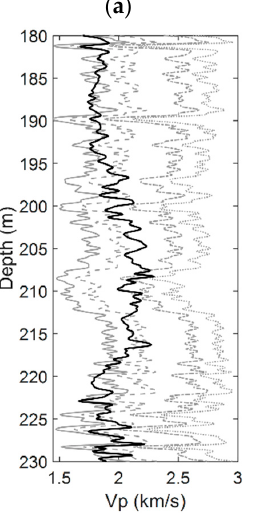
Figure 9. ( a ) Modeled V P of the marine sediments and ( b ) measured S gh for core samples from SH2 well. ( c ) Modeled V P of the marine sediments and ( d ) measured S gh for core samples from SH17 well. Table 1. Properties of the constituents used in rock physics modeling [37,38].